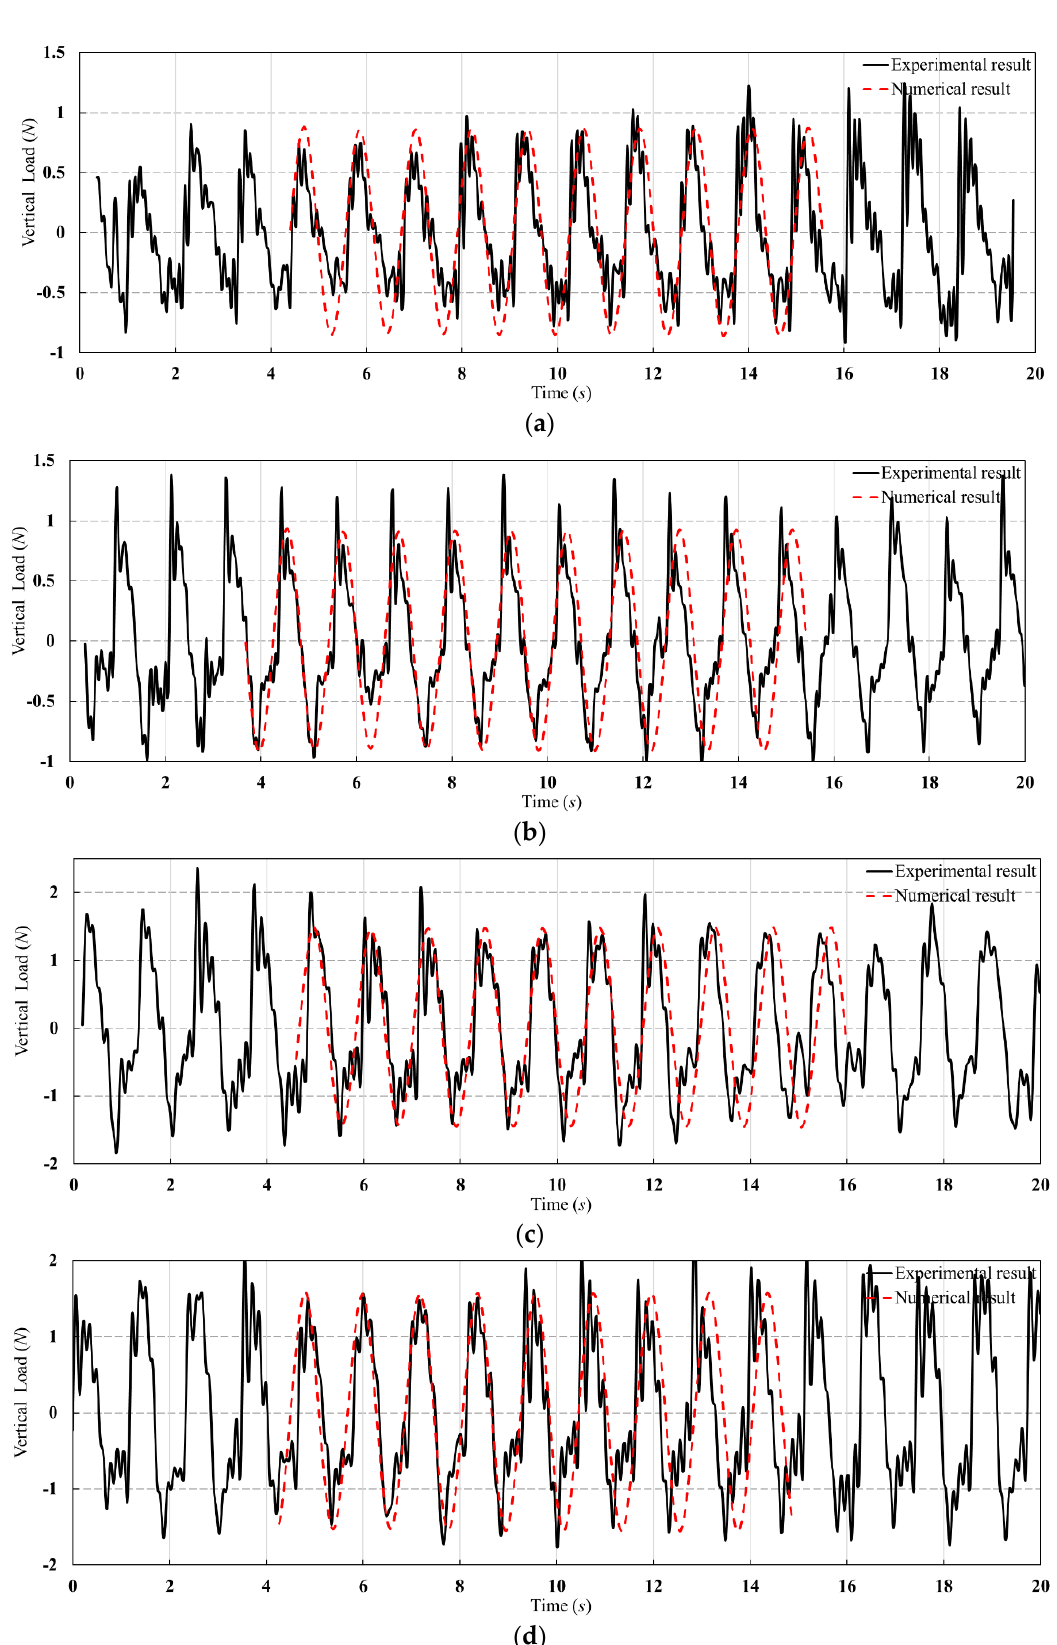
Figure 9. The longitudinal load time history in conditions height − 1~height − 4: ( a ) height − 1; ( b ) height − 2; ( c ) height − 3; ( d ) height − 4.